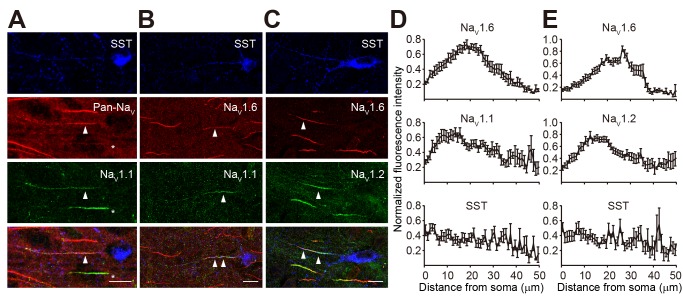
Polarized distribution of channel subtypes at the AIS of SST neurons.(A) Triple staining using antibodies for SST (blue), Pan-NaV (red), and NaV1.1 (green) show modest intensity of NaV1.1 immunosignals at the AIS (arrowheads) and adjacent axon regions of SST neuron. Asterisks indicate a neighboring SST-negative axon (presumably PV axon) that was heavily stained. Nearby PC axons were not stained. (B) Triple staining for SST, NaV1.6 (red), and NaV1.1 (green) indicates co-localization of the two subtypes at the AIS. (C) Triple staining shows polarized distribution of NaV1.2 (proximal region) and NaV1.6 (distal region) at the AIS. (D and E) Plots of the averaged fluorescence intensity (± s.e.m.) as a function of distance from the soma. Data were obtained from triple-staining experiments similar to (B) and (C). Images are projections of confocal z stacks. Scale bars represent 10 µm. Error bars represent s.e.m.